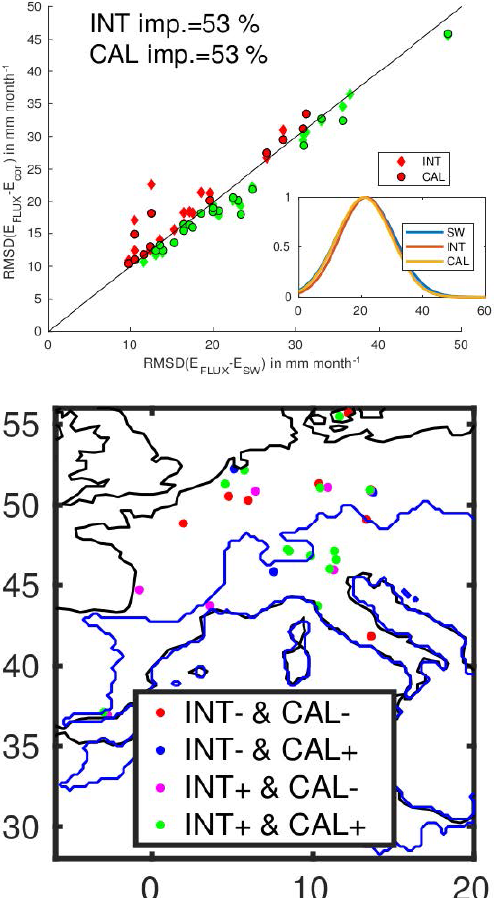
Figure 4. Top panel: scatterplot of the rmsd between FLUXnet sta- tion and the SW, INT and CAL products, for evapotranspiration. Dots under the 1 : 1 line (green) show improvement, and dots over the line (red) show degradation. INT and CAL results are super- posed for some locations, meaning that the linear approximation in CAL is enough to mimic the INT scaling factors at these location. The encapsulated figure shows the distribution of the differences with the Fluxnet estimates. Bottom panel: location of the FLUXnet stations used for validation: green dots show an improvement for INT and CAL compared to SW (INT + and CAL + ), blue dots show improvement only for CAL (INT − and CAL + ), and magenta only for INT (INT + and CAL − ). Red dots is where no improvement is observed (INT − and CAL − ). Blue line limits the total basin area.